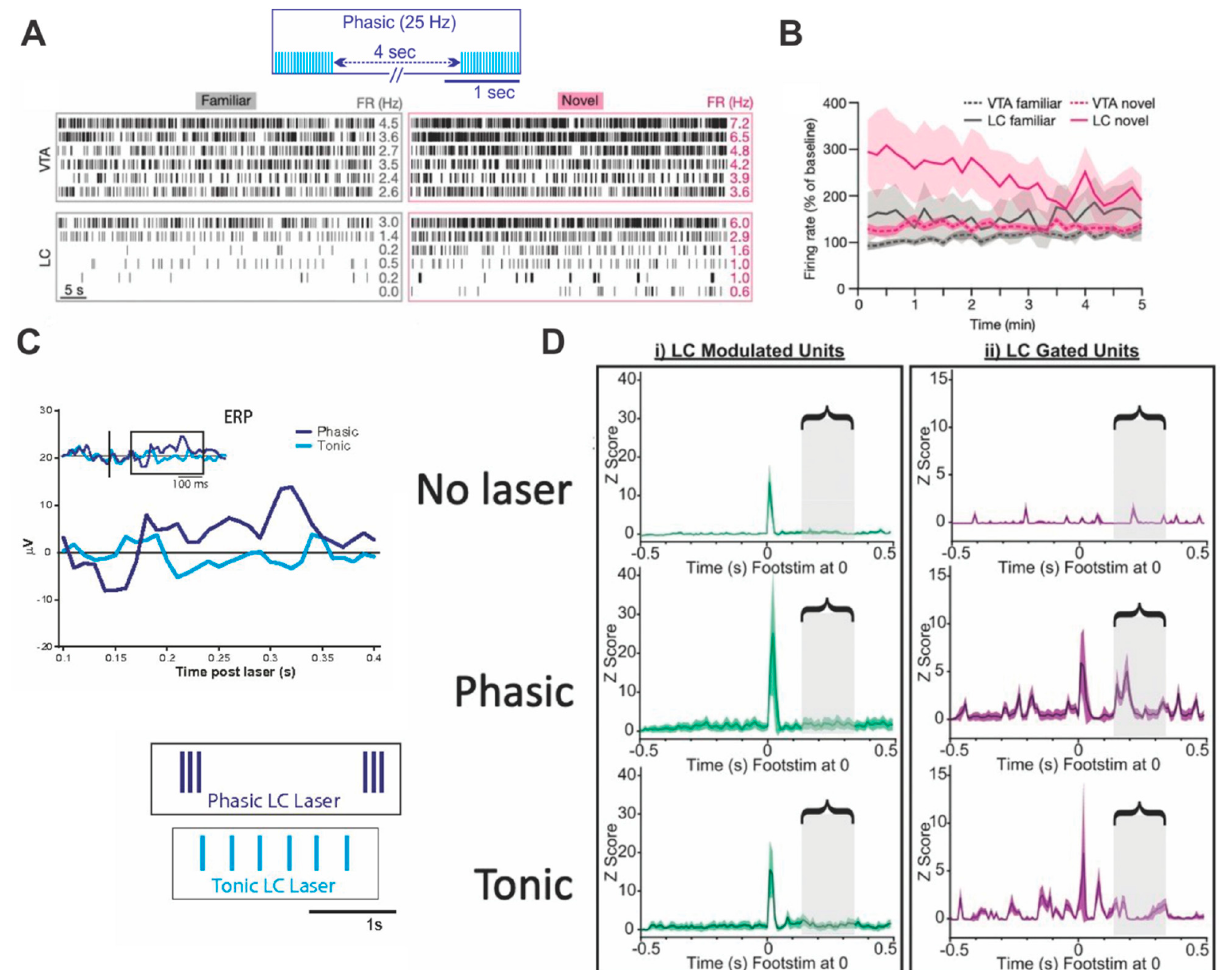
Figure 4. Phasic LC activation produces novelty-related memory extension and mimics sensory salience. ( A ) Ventral tegmental area (VTA) neurons and locus coeruleus (LC) neurons firing in a familiar versus novel environment are shown. Corresponding raster lines in the two settings are the same unit sampled for 1 min. The cartoon shows the phasic optogenetic pattern used to mimic novel environment firing of LC neurons. ( B ) The average of 15 neurons from 5 mice over the 5 min period in the two environments. LC units show habituation in firing rate. Reprinted from [30] 2016 Springer Nature BV. ( C ) Averaged event related potentials (ERP; n = 50 events) from the medial prefrontal cortex. Response times locked to phasic LC onset show N1- and P3-like components not seen with the tonic LC pattern. Cartoons show phasic and tonic patterns matched for number over 1 s. ( D ) Hindlimb evoked responses to a weak shock without LC photoactivation, with phasic LC photoactivation and with tonic LC photoactivation. Green lines represent early latency hindlimb responses that were always present to shock but were modulated by concurrent LC activation. Purple lines represent early and longer latency responses that were seen in nearby somatosensory neuron populations only when LC was concurrently activated (LC gated units). Adapted with permission from [31] 2018 PNAS.